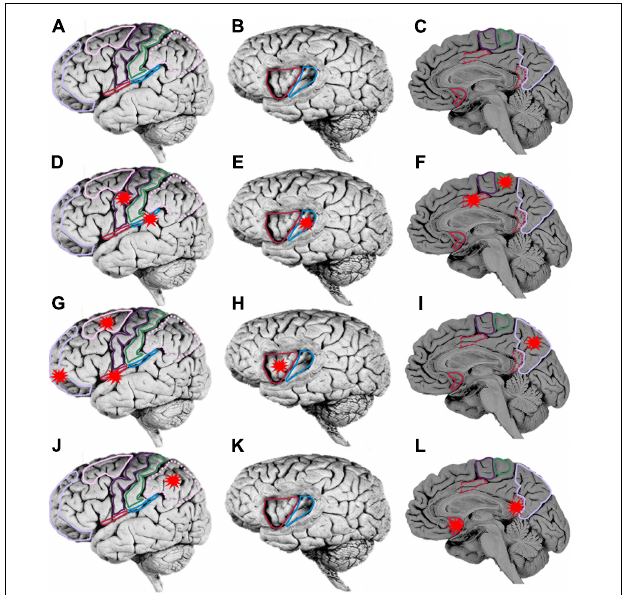
FIGURE 5 | Localization of human brain regions. (A,D,G,J) Lateral view of brain, orbitofrontal cortex (mauve), dorsolateral prefrontal cortex (pink), motor cortex (purple), somatosensory cortex (green), posterior parietal cortex (dotted pink), lateral margin of frontal operculum (red), lateral margin of parietal operculum (blue). On a lateral view only the lateral margins of the operculum are exposed. The operculum forms the roof of the lateral sulcus and is only accessible by removal of the temporal lobe (which forms the ventral floor of the lateral sulcus). (B,E,H,K) Lateral view of brain with partial frontoparietal lobe removed to reveal underlying gyri of insula, anterior insula (red), posterior insula (green). (C,F,I,L) Medial wall of brain, perigenual anterior cingulate cortex (red), posterior mid cingulate cortex (dashed red), ventral posterior cingulate cortex (dotted red), supplementary motor area (purple), somatosensory cortex (green), and precuneus (pink). Each of the three rows starting at (D,G,J) represent a temporal sequence of cortical activation (red stars). (D–F) After initial activation of the somatosensory area there is co-activation of five cortical areas (G–I) . A third wave of co-activation of five cortical area. (J–L) A fourth wave of co-activation of three cortical